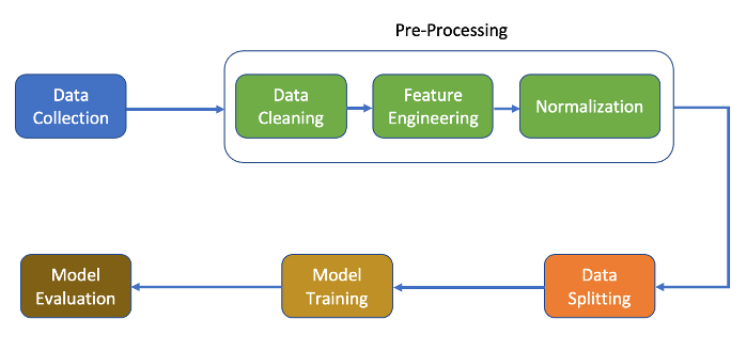
Figure 1. Research workflow